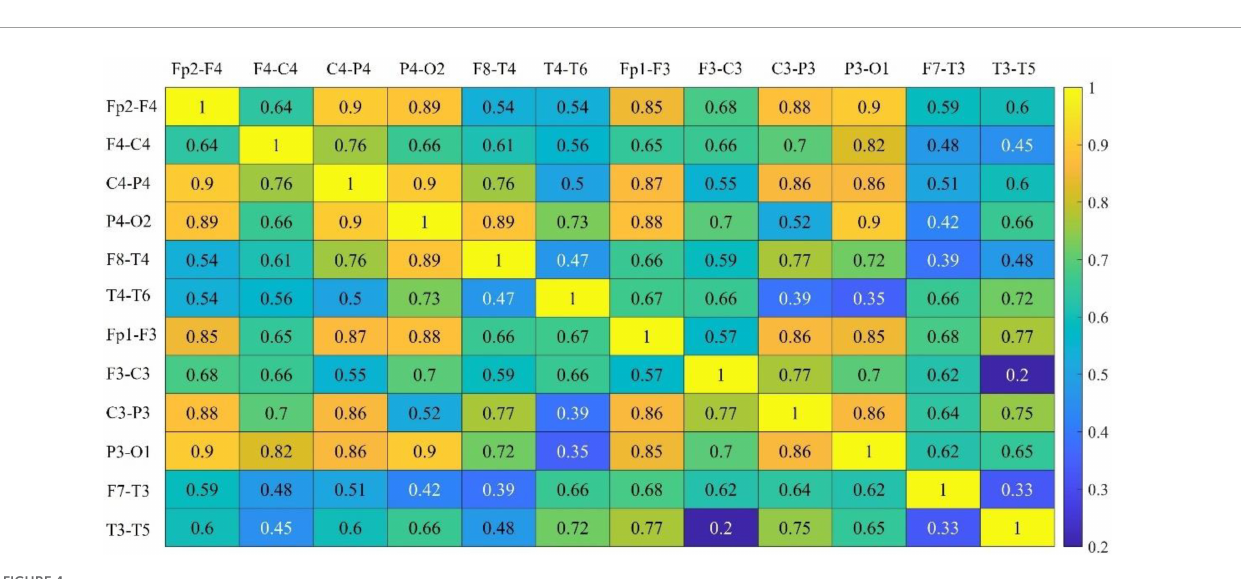
FIGURE4 Communication strength of all